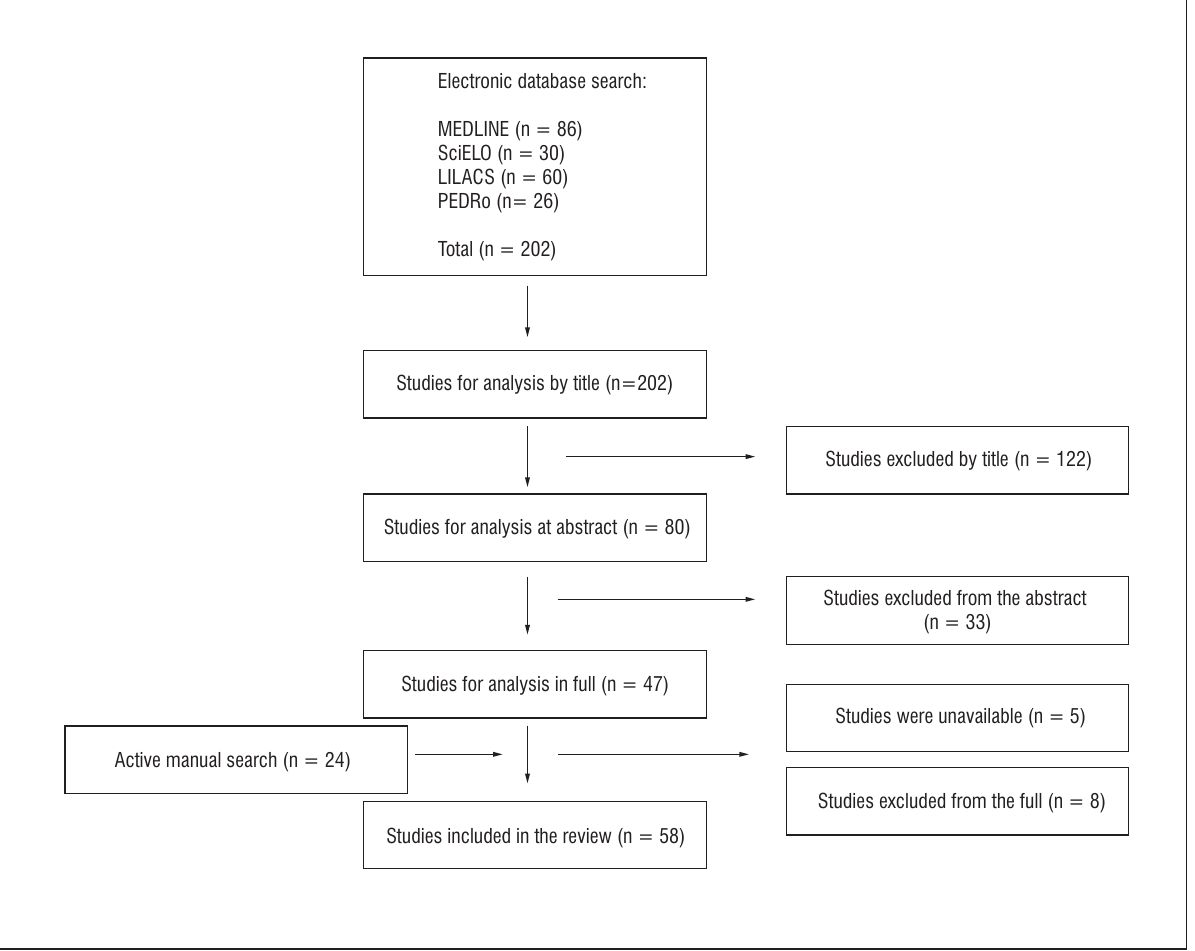
Figure 1 - Flow chart of the selection of the